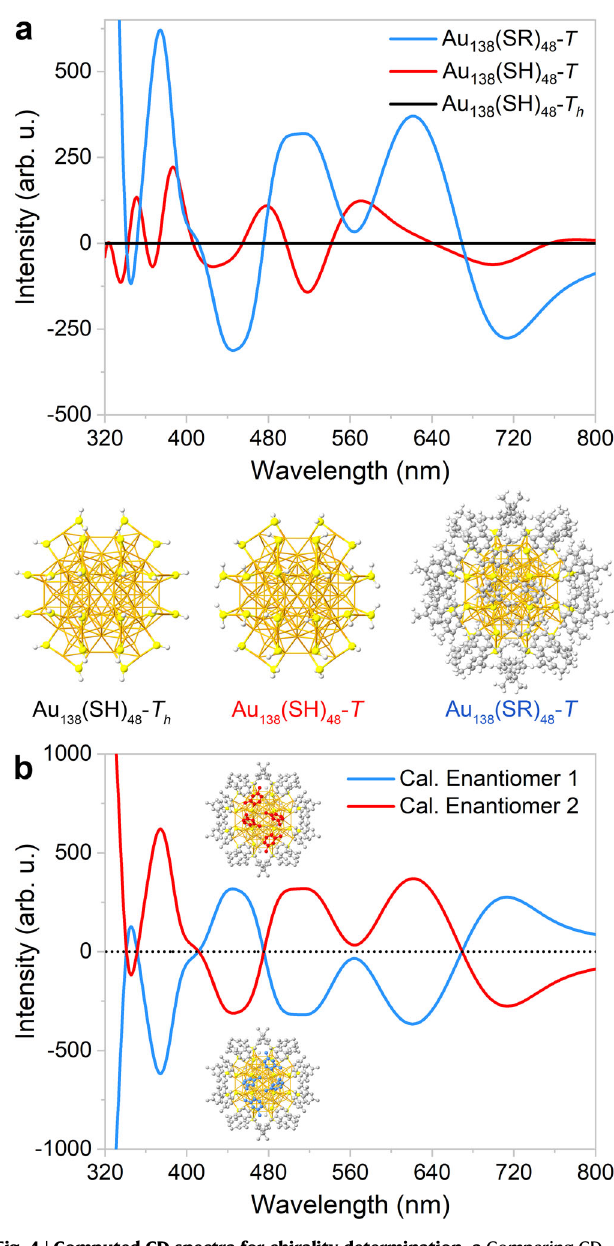
Fig. 4 | Computed CD spectra for chirality determination. a Comparing CD spectraoftherelatedAu 138 clustersobtainedbysimpli fi edtime-dependentdensity functional theory (STDDFT) formalism and PBE/SVP level of theory. For the Au 138 (SH) 48 cluster with a T h symmetry, H atoms were placed on preserving the symmetryoftheremainingAu 138 S 48 fragment.Fortheothertwoclusters,geometry optimizations were performed for the ligands without any constraints on sym- metry. All the clusters were generated from the crystal structure of Enantiomer 2. b Mirror-image CD spectra of Au 138 (SR) 48 . The optimized enantiomeric structures aredepictedingreaterdetailinSupplementaryFig.17.Sourcedataareprovidedas a Source Data fi